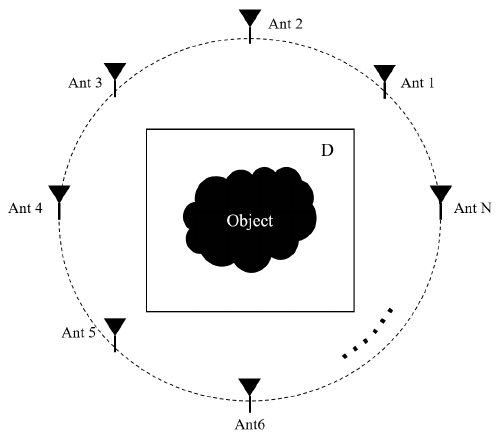
Figure 1. An example of a 2-D inverse